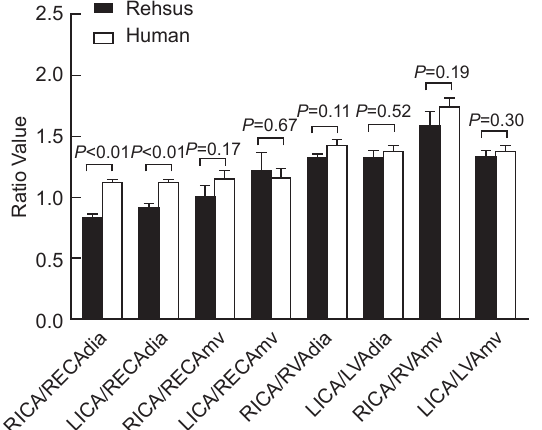
Figure 2 Carotid artery diameter and velocity ratios of ICA/ECA and ICA/VA were compared between human and rhesus macaques.